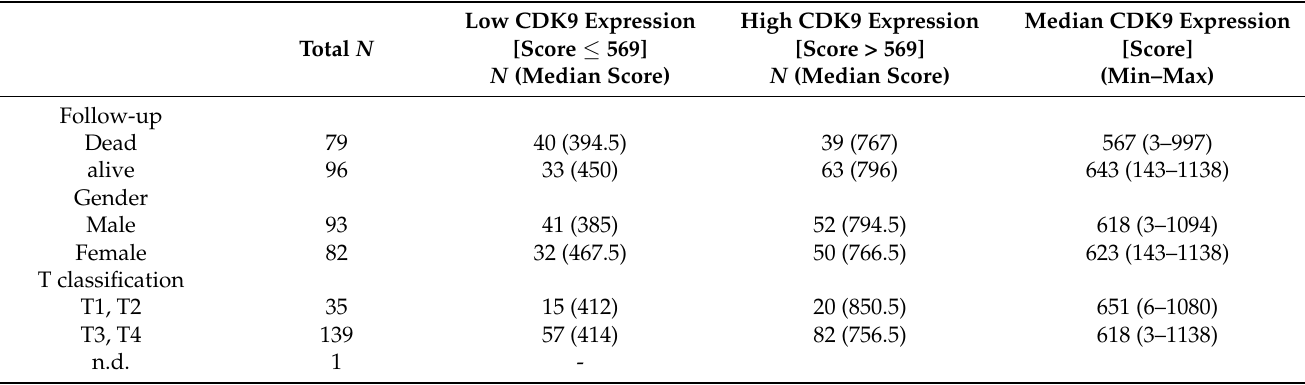
Figure 1. CDK9 expression in normal and colorectal cancer tissue and cell lines. ( a ) Representative pictures of CDK9-Immunohistochemistry and HE staining in human normal and CRC tissue. A,E: CDK-9 IHC staining in normal (A) and tumor tissue (E) of patient 165; B,F: CDK-9 IHC staining in normal (B) and tumor tissue (F) of patient 89; C,G: HE staining in normal (C) and tumor tissue (G) of patient 165; D,H: HE staining in normal (D) and tumor tissue (H) of patient 89 ( b ) Statistical significance between groups was determined using Wilcoxon signed-rank test for group comparison demonstrated by a boxplot. p values of <0.05 were considered statistically significant. *** p < 0.001. ( c ) CDK9 expression was also shown in different colorectal cancer cell lines. Cells were lysed and subjected to western blotting. One representative of two independent experiments is shown. Table 2. Correlation of CDK9 expression with clinicopathologic parameters of